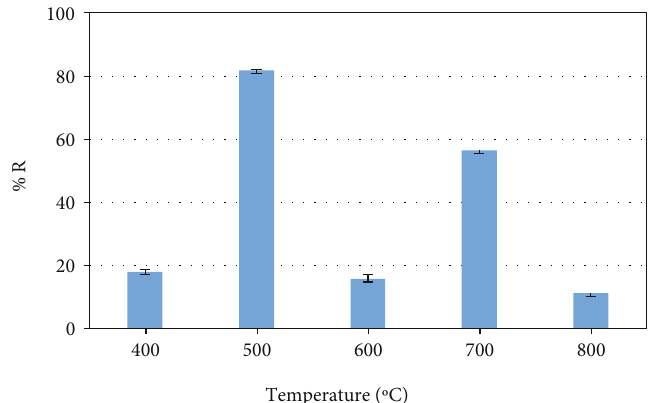
Figure 1: The performance of biochar produced by various pyrolysis temperatures on removing MB dye from solution (room temperature, unadjusted pH, C i = 100 ppm , and contact time of 3h).